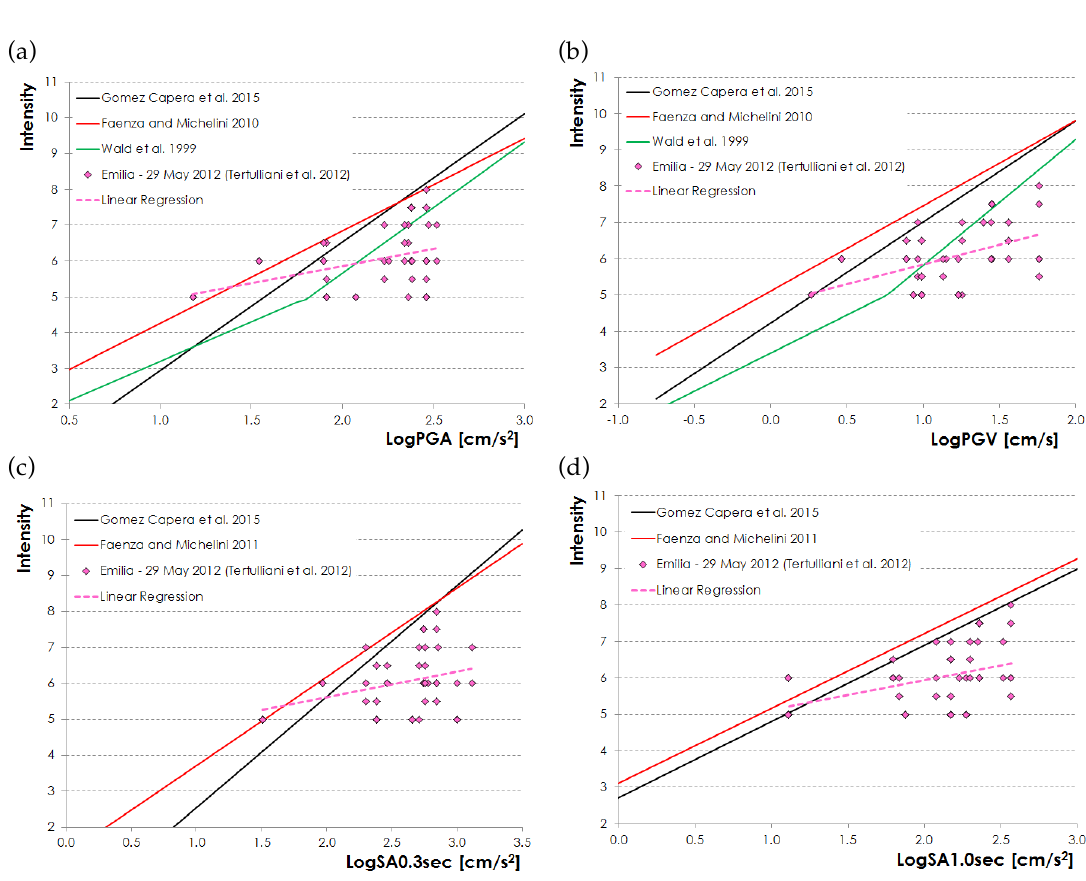
Figure 5: Comparisons between I for the 29 May 2012 Emilia second mainshock (Tertulliani et al. 2012) and pre- EMS dicted MCS values from literature models based on PGA (a), PGV (b), SA(0.3) (c) and SA(1.0) (d)